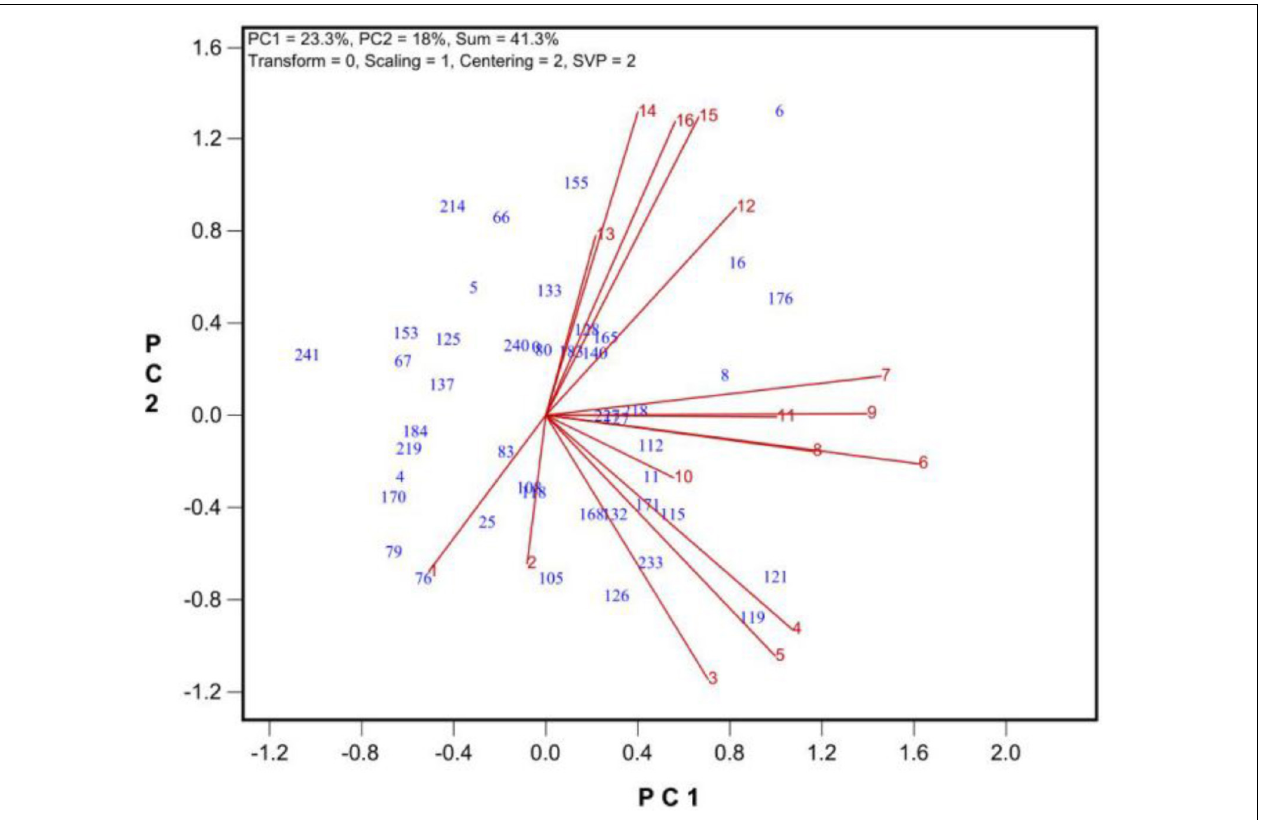
FIGURE 4 | The similarity/dissimilarity in genotypic diffidences in grain set under 9 levels of salt stress (treatments 2 to 10) and 6 levels of alkali stress (treatment 11 to 16) plus the control (treatment 1). See Table 2 for descriptions of the treatments.